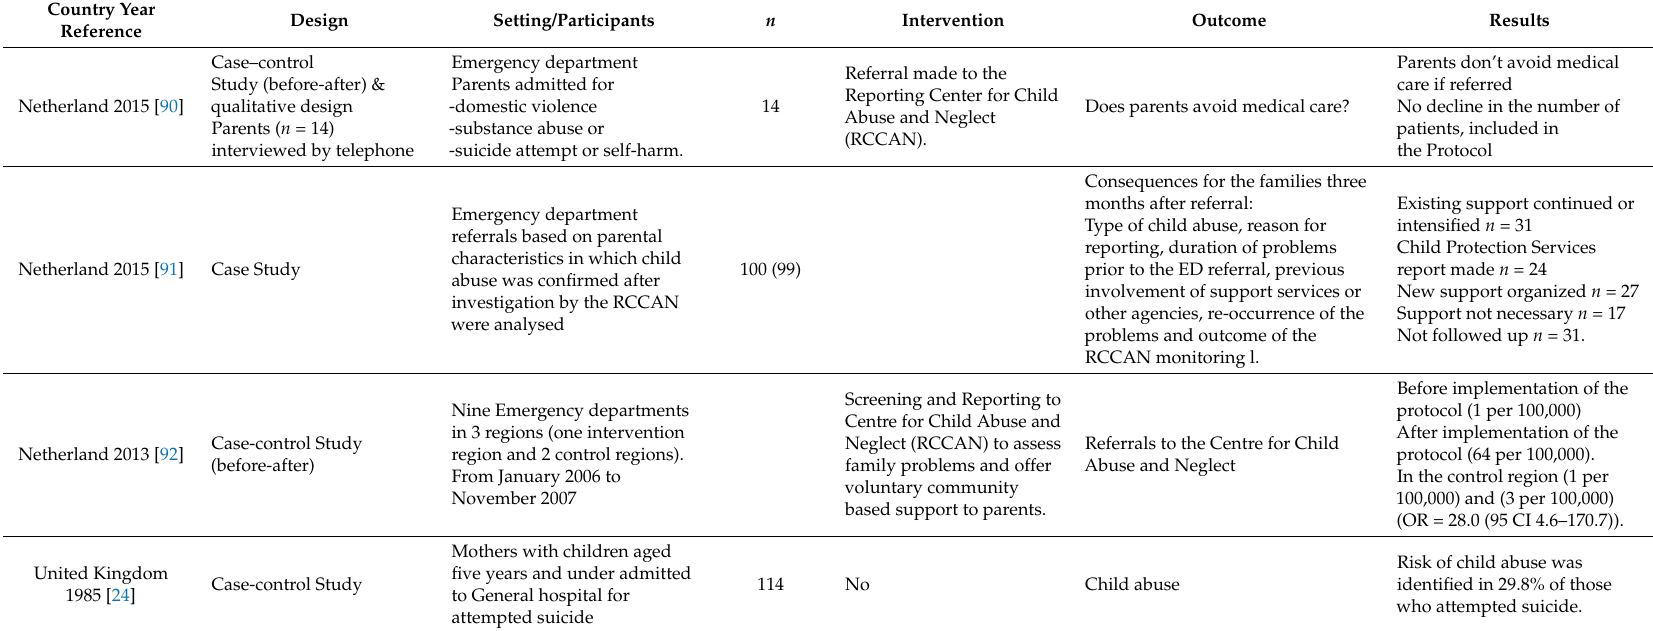
Table 1. Overview of the studies included in the